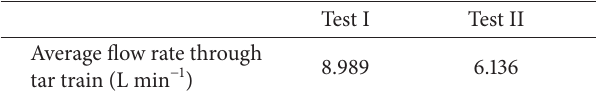
Table 2: Gasification parameters in tests I and